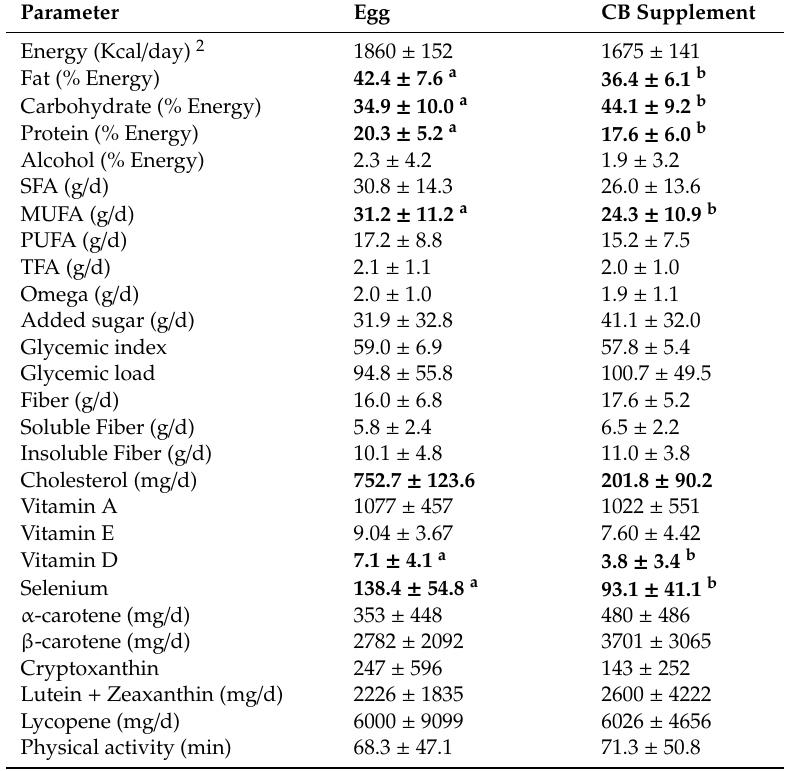
Table 1. Comparison of macronutrients, cholesterol, choline, dietary fiber, and carotenoids between the egg and choline bitartrate (CB) supplement periods 1 .